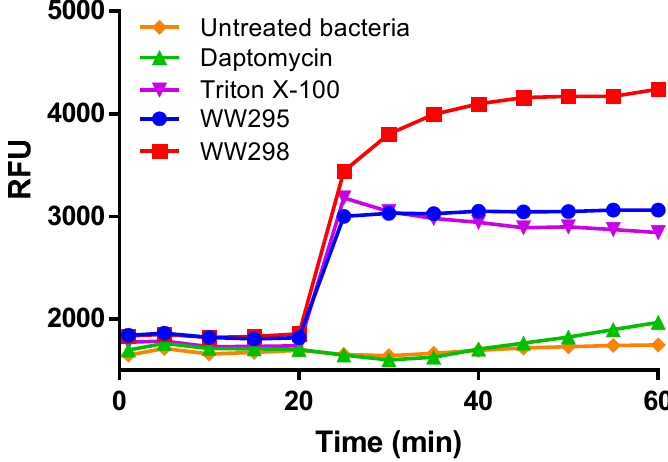
Figure 5. Membrane depolarization of S. aureus USA300 by WW295 and WW298. Plots shown here are at 12.5 µM of peptide concentration plotted as a function of relative fluorescence units with time.